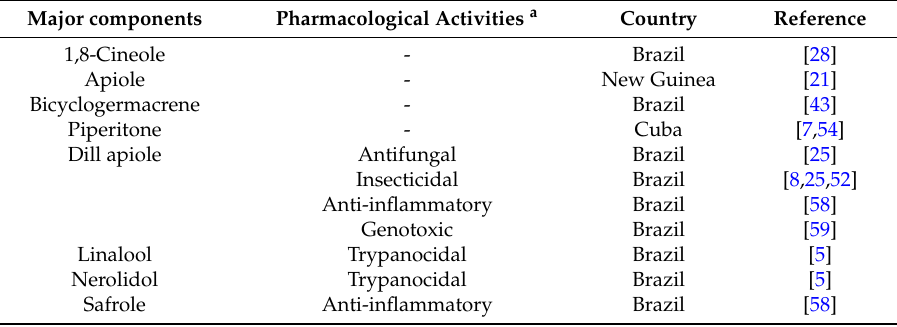
Table 5. Major chemical constituents reported for essential oils of Piper aduncum